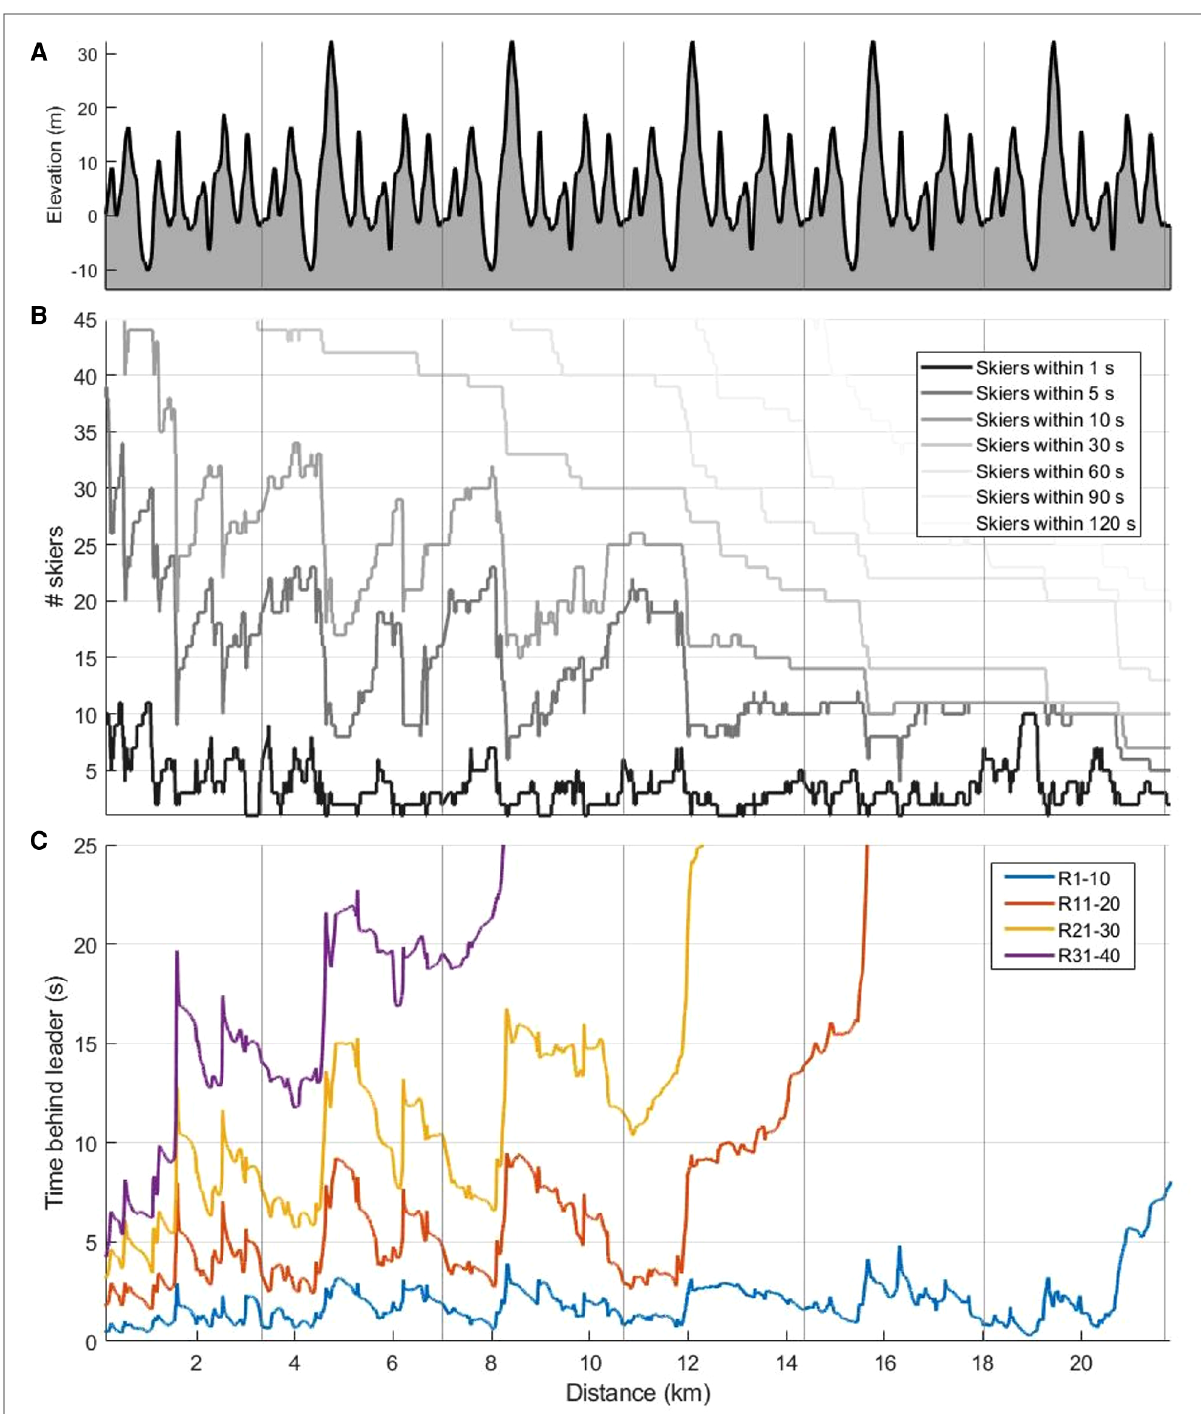
FIGURE 6 Elevation [m] ( A ), number of skiers within 1, 5, 10, 30, 60, 90 and 120 s from the current leader ( B ) and mean time behind the current leader for the different performance-groups ( C ) as a function of distance [km] in a 21.8 km cross-country skiing mass-start competition. Here, the accordion effect is clearly seen as fl uctuating values from 0 to ∼ 12 km particularly in relation to the longest uphill in for the two lines “ skiers within 5 s ” and “ skiers within 10 s ” , and for the three lowest performance-groups (R11 – 20, R21 – 30, R31 – 40). R1 – 10 denotes ranks 1 – 10, R11 – 20 ranks 11 – 20, R21 – 30 ranks 21 – 30, and R31 – 40 ranks 31 –